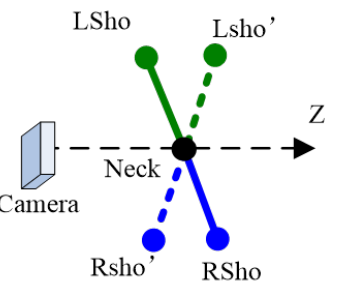
Figure 2. The ambiguity of Shoulders with the same 2D projection.